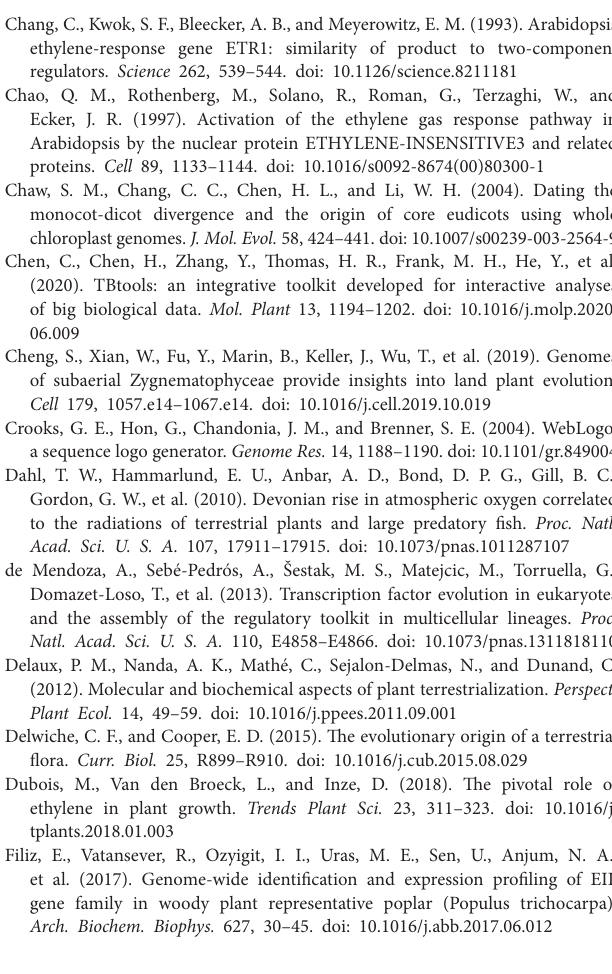
Supplementary Figure S7 | Sequence alignment of A3 subgroup EIL proteins. Supplementary Figure S8 | Sequence alignment of B1 subgroup EIL proteins.